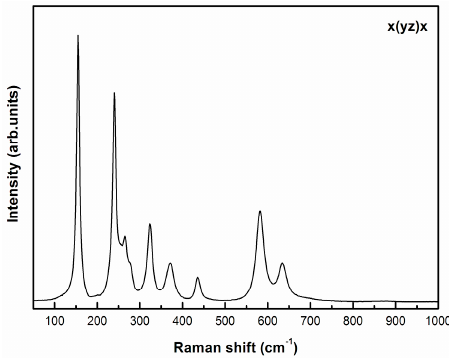
Figure 3. Room-temperature Raman spectrum of the Mg: 7 LiNbO 3 crystal recorded in the x(yz)x configuration.